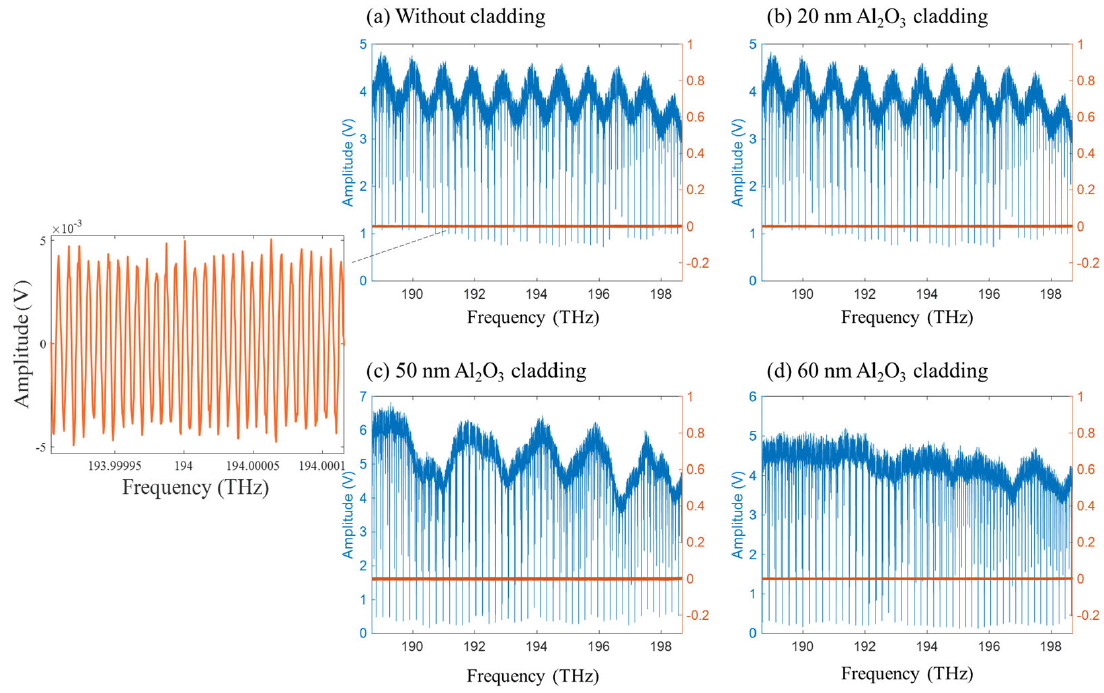
Figure 7. Transmission spectra and interference fringes (orange lines) of the ( a ) air-cladded, ( b ) 20 nm, ( c ) 50 nm, and ( d ) 60 nm ALD-cladded devices.